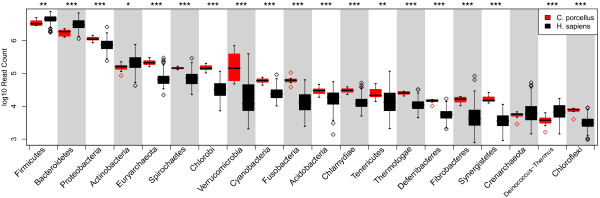
Most prevalent phyla. The 20 most prevalent bacterial phyla in guinea pigs (red) and humans (black). Asterisks denote significant differences in abundance, * : q-value < 0.1, ** : q-value < 0.05 and *** : q-value < 0.01. A complete list of the most abundant taxons is given in Table
1.